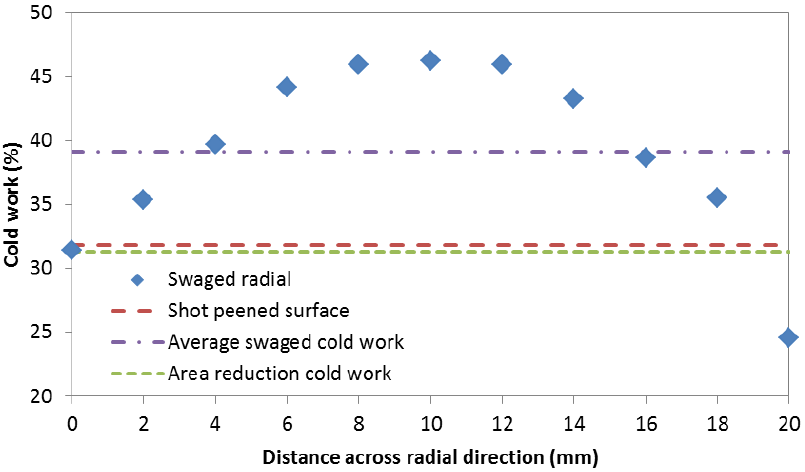
Figure 14. Cold work predicted from the full width half maximum (FWHM) measurements on a radial section of swaged material compared to average level predicted from bulk area reduction.